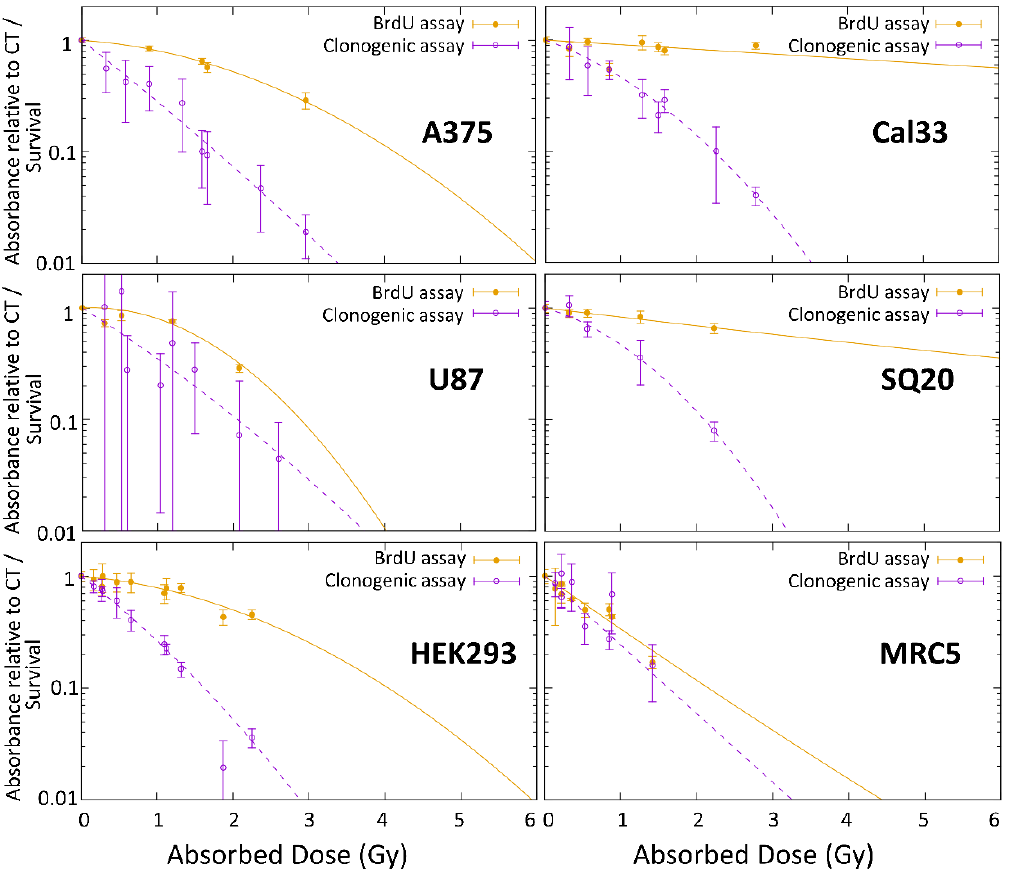
Figure 5. Proliferation and survival data for the different cell lines in response to neutron irradiation. Proliferation (expressed as absorbance relative to control (CT), as determined by BrdU assay), and survival (based on clonogenic assays) are represented for each cell line as a function of the total absorbed dose after neutron irradiation at ILL. Data were obtained from between two and four individual experiments with three replicate dishes plated per point per experiment.